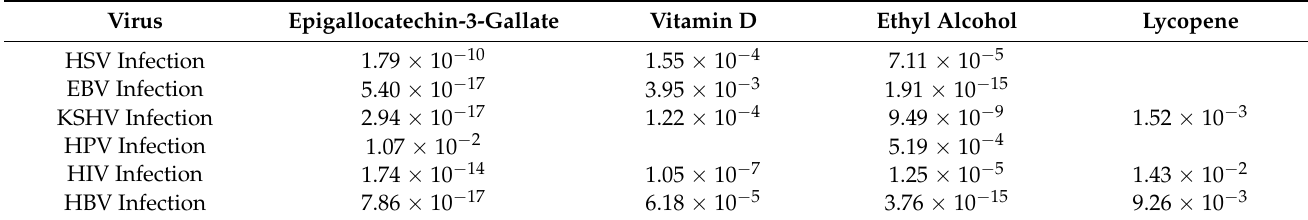
Table 1. Nutrients that significantly interact with multiple viral